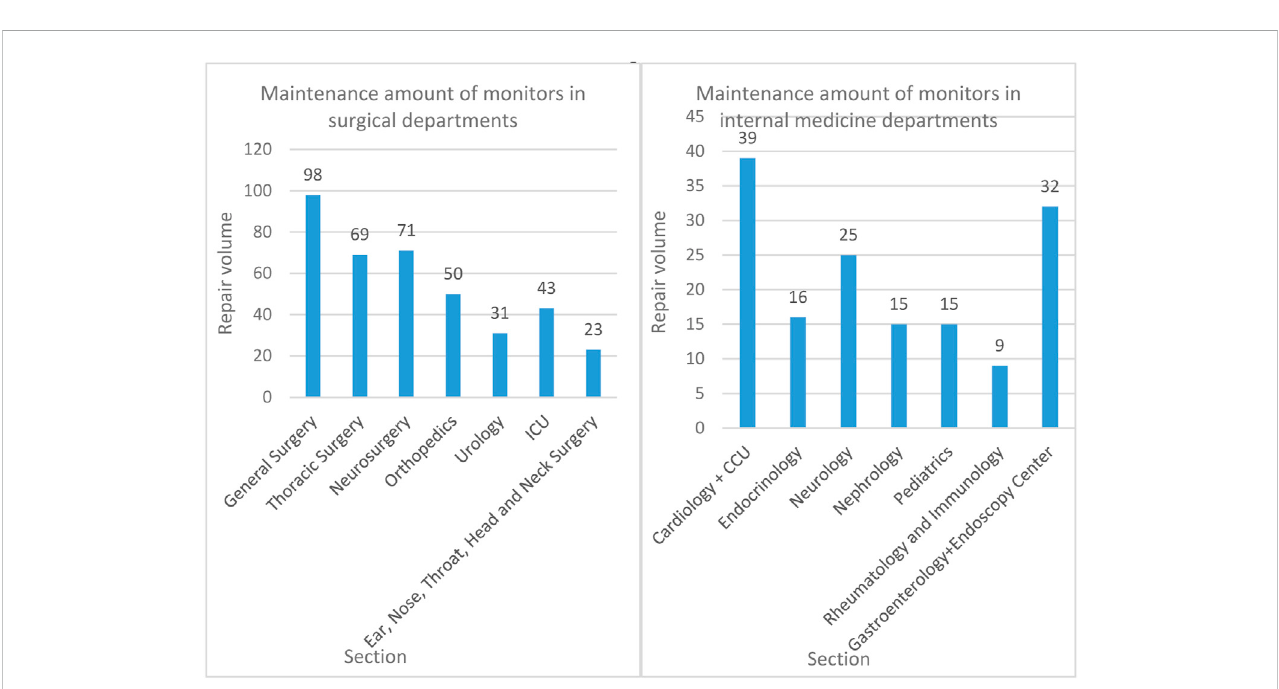
FIGURE 6 Statistical chart of monitor maintenance volume between some